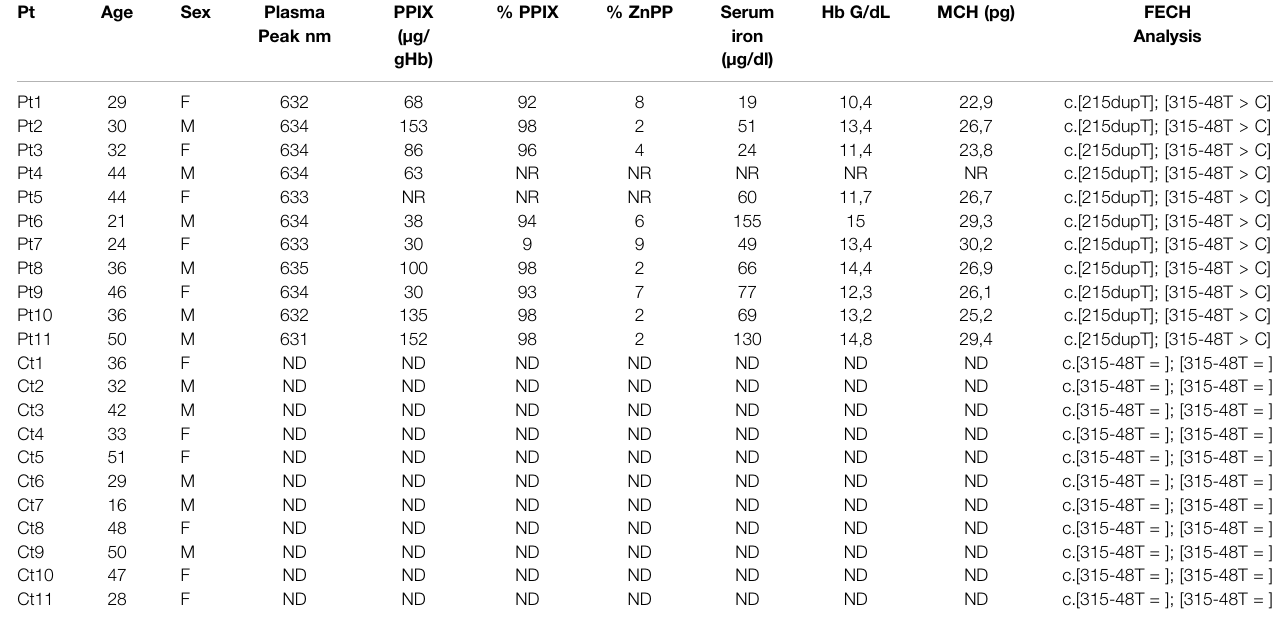
TABLE 1 | Clinical and biochemical fi ndings: PPIX [reference range: 0.0 – 3.0 µg/gHb] with percentage of PPIX [85 — 100%] and ZnPP [0 — 15%]; serum iron with ranges for female [37 – 145 μ g/dl] and male [59 – 158 μ g/dl]; MCH for female [25 – 35 pg] and male [25 – 35 pg]; Plasma peak and FECH genotype (Pt = patients; Ct = controls; NR = not reported in clinical folder; ND Not detected).